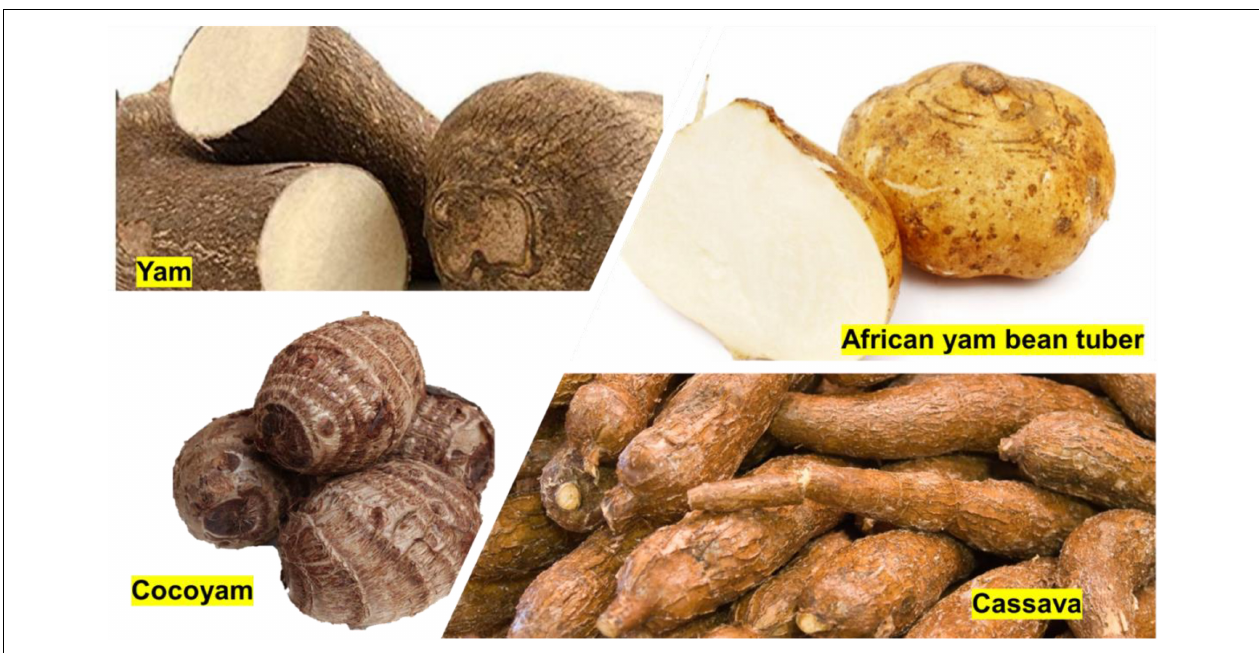
FIGURE 2 | African tuber crops (https://www.google.com/search?q=tuber+crops+in+africa&sxsrf=AOaemvIjAfPFMI4V4BheAZXga3ORPC33wQ: 1637923213131&source=lnms&tbm=isch&sa=X&ved=2ahUKEwjPlqa667~$ \